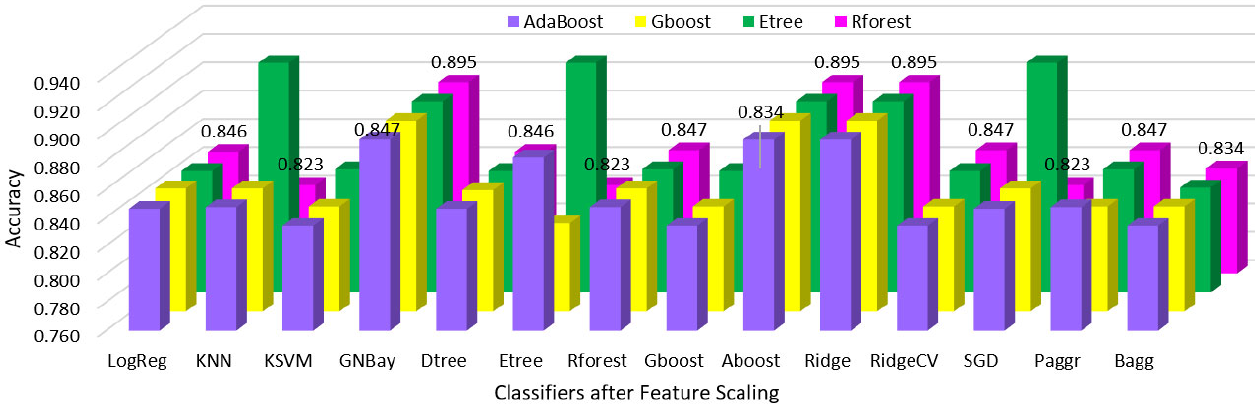
Figure 8. Regressor feature importance performance of all classifiers after scaling.